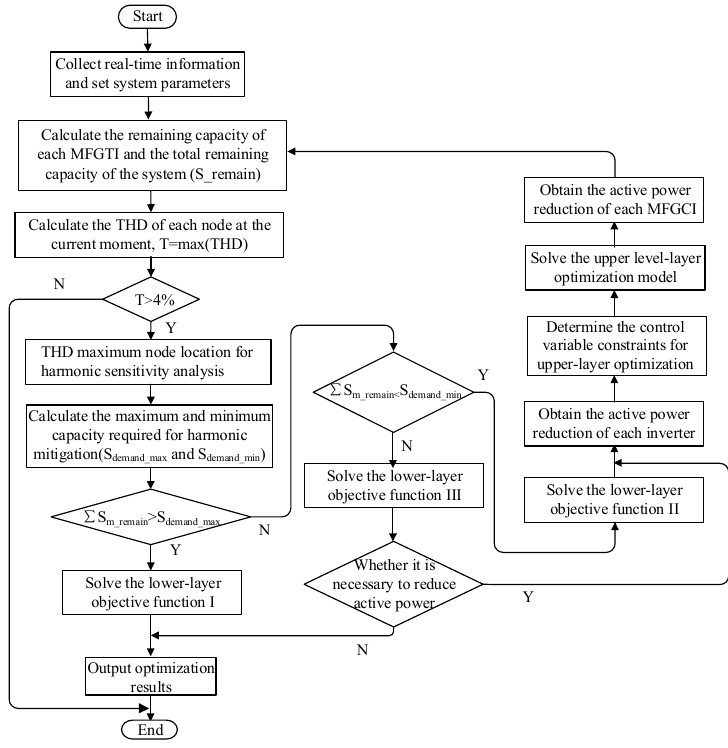
Figure 5. The flow chart of solving the two-layer optimization model.